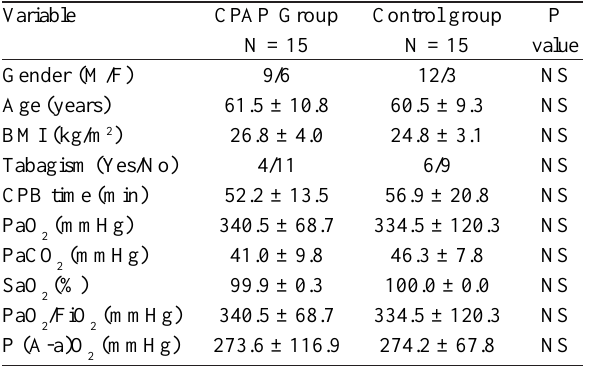
Fig. 2 - PaO /FiO (mmHg) at different observation times. - PaO 2 2 FiO (mmHg) at different observation times. Statistically significant 2 differences were found between times for both groups. * pT <